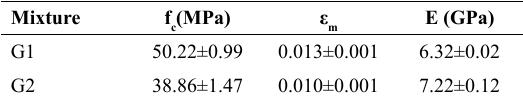
Figure 9. Stress-strain curves for the geopolymer binders Table 9. Compression mechanical parameters for the geopolymer binders.